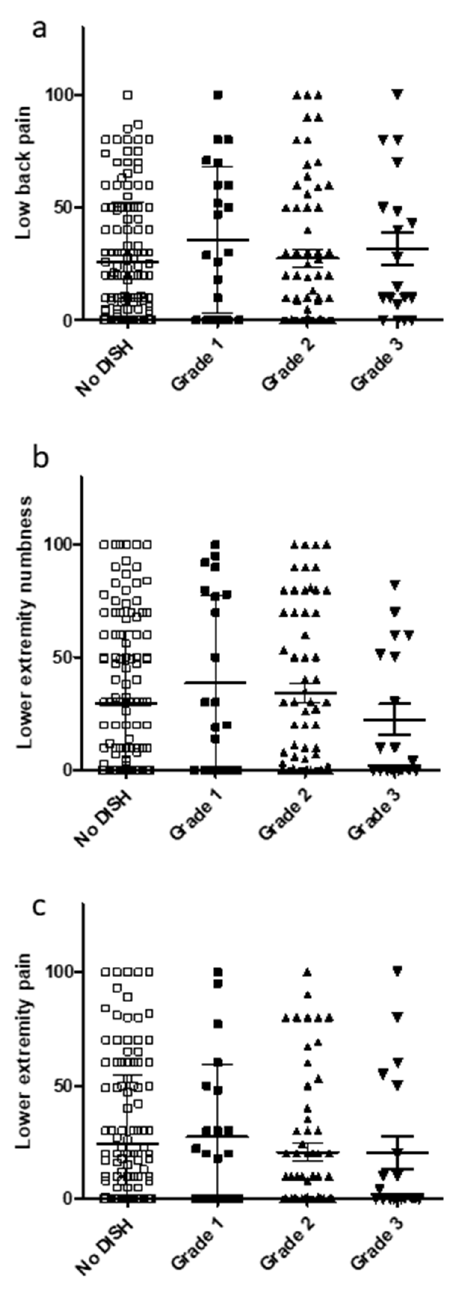
Figure 6. Relationship between the VAS scores included in the JOA-BPEQ and DISH grade. VAS scores for ( a ) low back pain, ( b ) lower extremity numbness, and ( c ) lower extremity pain. DISH, diffuse idiopathic skeletal hyperostosis; JOA-BPEQ, Japanese Orthopaedic Association Back Pain Evaluation Questionnaire; VAS, visual analog scale.